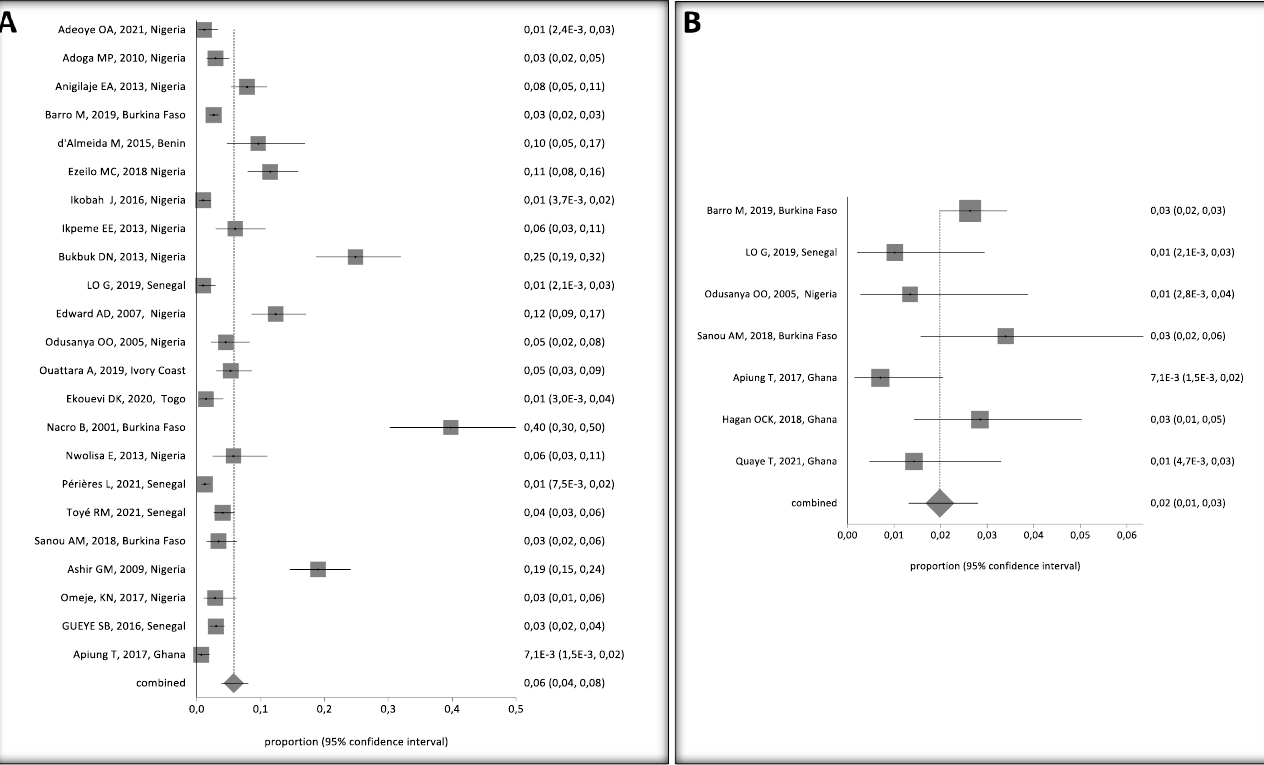
Figure 9. ( A ) HBV Prevalence Among Unvaccinated and ( B ) Vaccinated Children [24 – 34,36 – 41,43,45 – 47,49]. A black square represents the HBV prevalence in the forest plot. The square position represents the prevalence in each study in the meta-analysis.